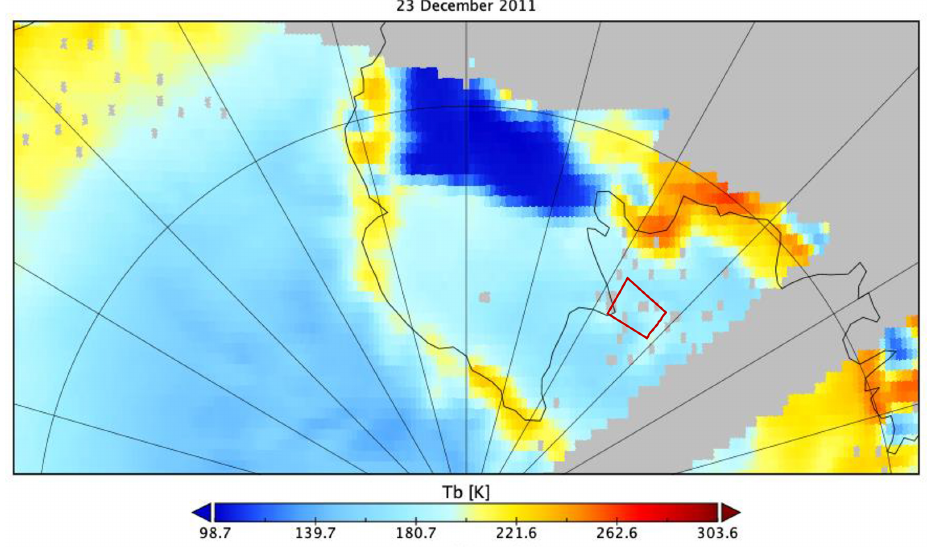
Figure B5. SSMIS horizontally polarized 19.35GHz brightness temperature over part of West Antarctica and the RIS on 24 December 2011, with the red box denoting the Siple Dome bounding